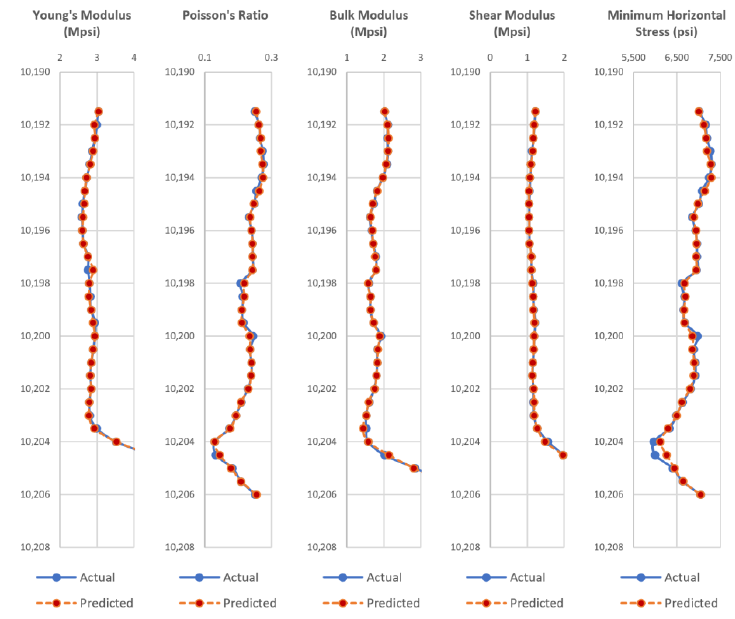
Figure A6. Actual and predicted geomechanical properties along with depth (feet) for test well 3 in Dunn County for the Middle Bakken Formation.